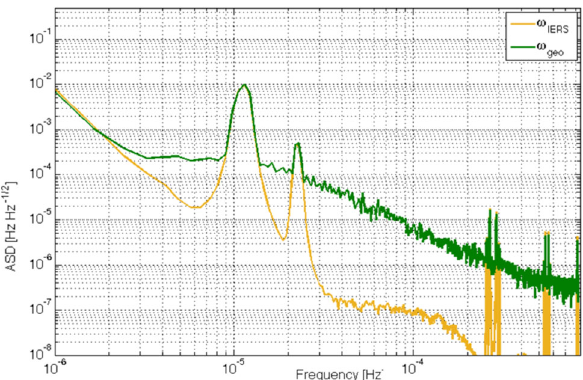
Fig. 4 Comparison of the ASD of ω IERS and ω geo : the main features due to polar motion and to solid Earth tide are clearly visible and well in agreement in both frequency and amplitude. Smaller and very tiny resonances at higher frequency are well visible